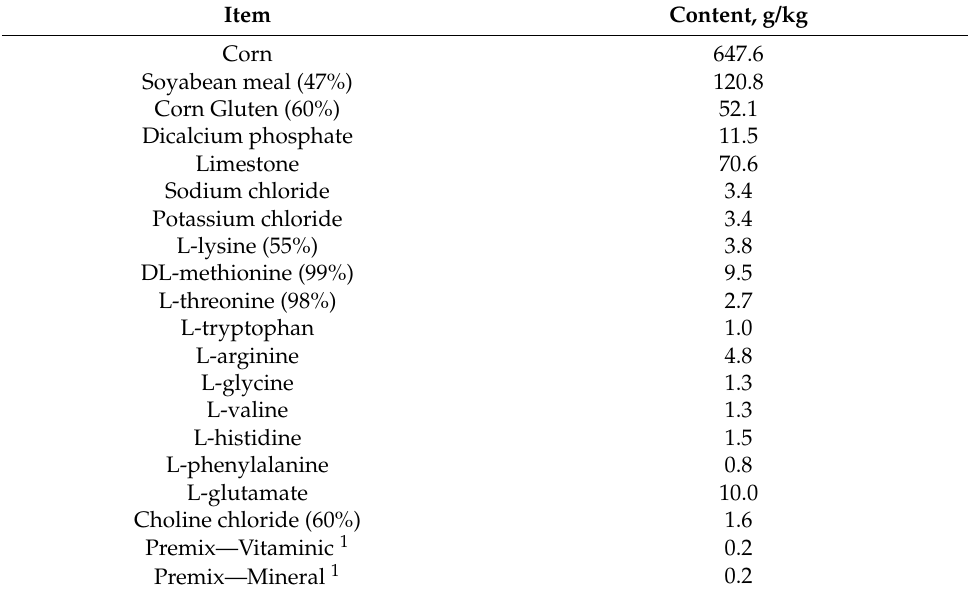
Table 1. Composition of the control diet (balanced